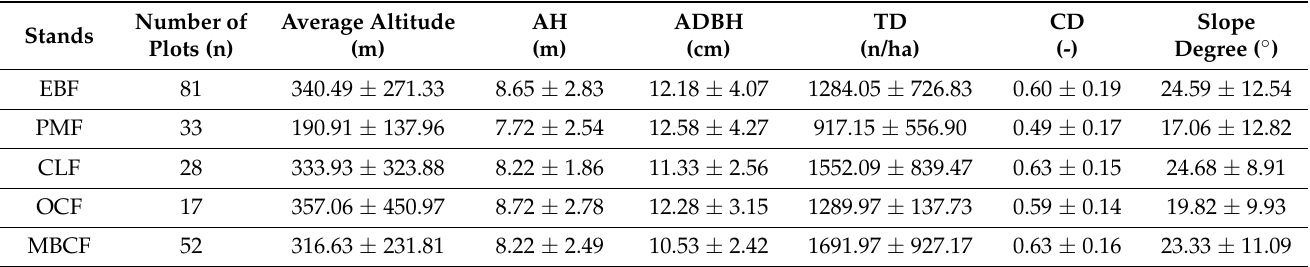
Table 1. Characteristics of experimental stands (Value ±